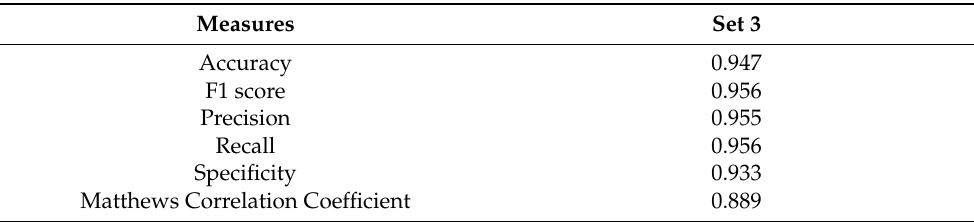
Table 9. Effectivity of the forward NN2 model for recognition of trolls learned on Set 3 (all attributes). Table 8. Architecture of NN2 model in the second experiment. The model was trained at 50